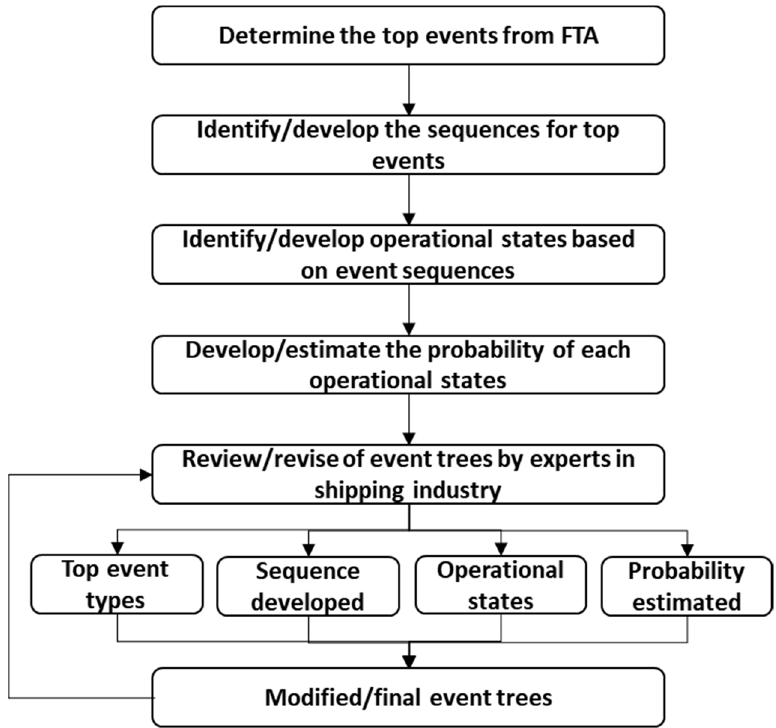
Figure 2. Fault tree assessment approach.